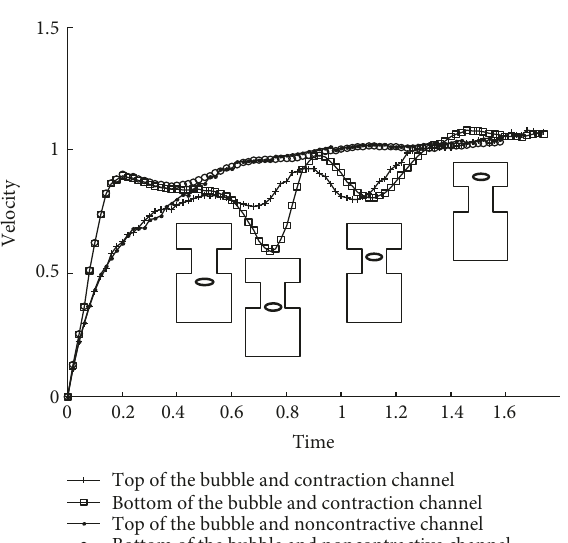
Figure 9: The centroid height of the bubble in the contractive and noncontractive channels (Re=70, Mo=1 × 10 − 5 , and